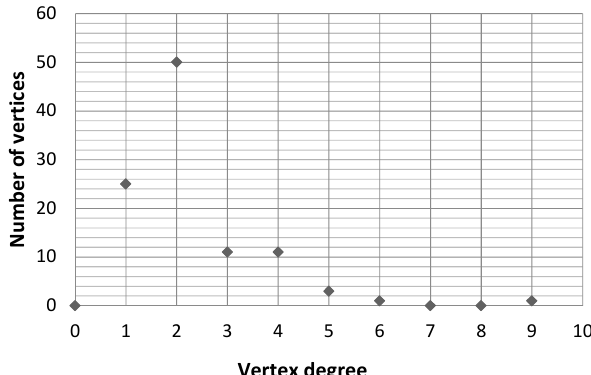
Figure 4. Graph vertices degree distribution. The value of k = 2 indicates that many vertices belong to different chains (sometimes rings). When some of them are removed, as a consequence some parts of the network (that do not belong to any ring) can be easily separated.